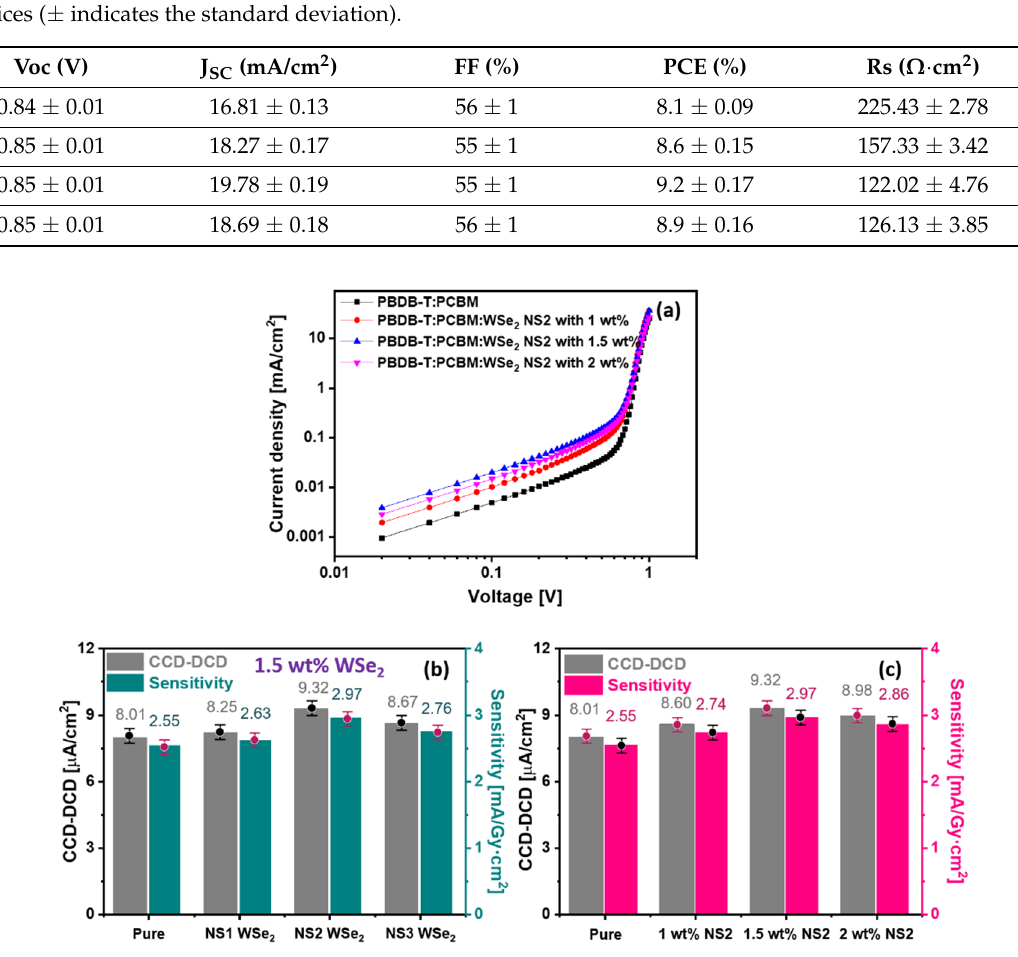
Figure 7. ( a ) Log J–V characteristics and ( b ) CCD-DCD and sensitivity variations (with the standard deviation error bar) Figure S1. NS3 WSe2 NSs blended PBDB-T:PCBM active layers as assessed by X-ray detectors; ( c ) CCD-DCD and sensitivity variations (with the standard deviation error bar) for